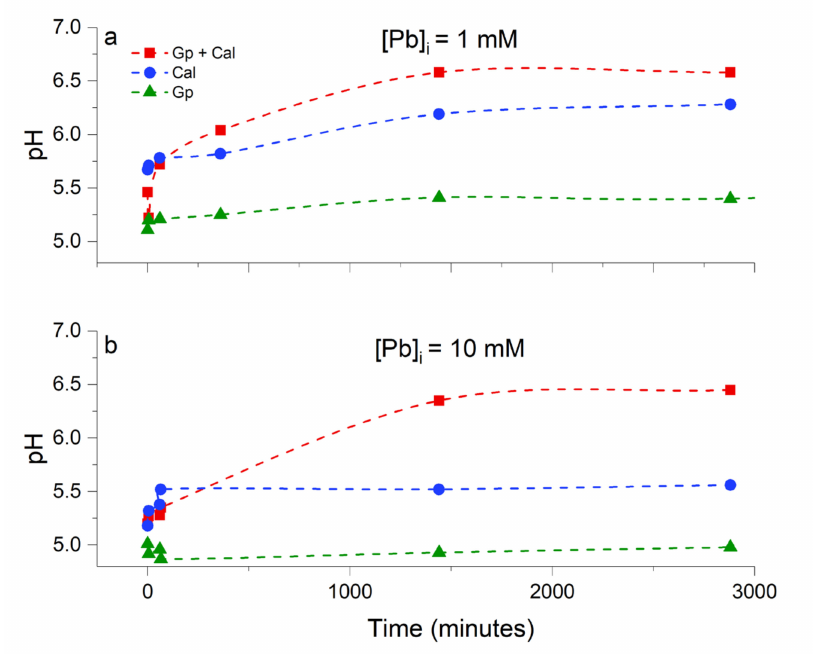
Figure 1. Evolution of the pH values during interaction of dissolved lead [Pb] i = 1 mM ( a ) and [Pb] i = 10 mM ( b ) with calcite (Cal), gypsum (Gp), and mixtures of both phases (Gp + Cal). The curves represent a modifier Bezier connection among the average values of three replicate